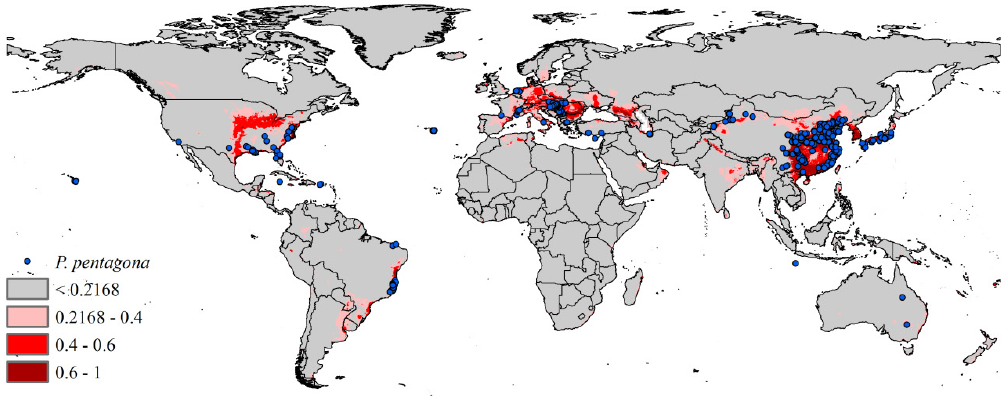
Figure 1. The occurrence sites and the potential distribution of Pseudaulacaspis pentagona used in current modeling. Blue point, occurrence sites; Gray, unsuitable habitat area; Pale red, low habitat suitability area; Red, moderate habitat suitability area; Dark red, high habitat suitability area.